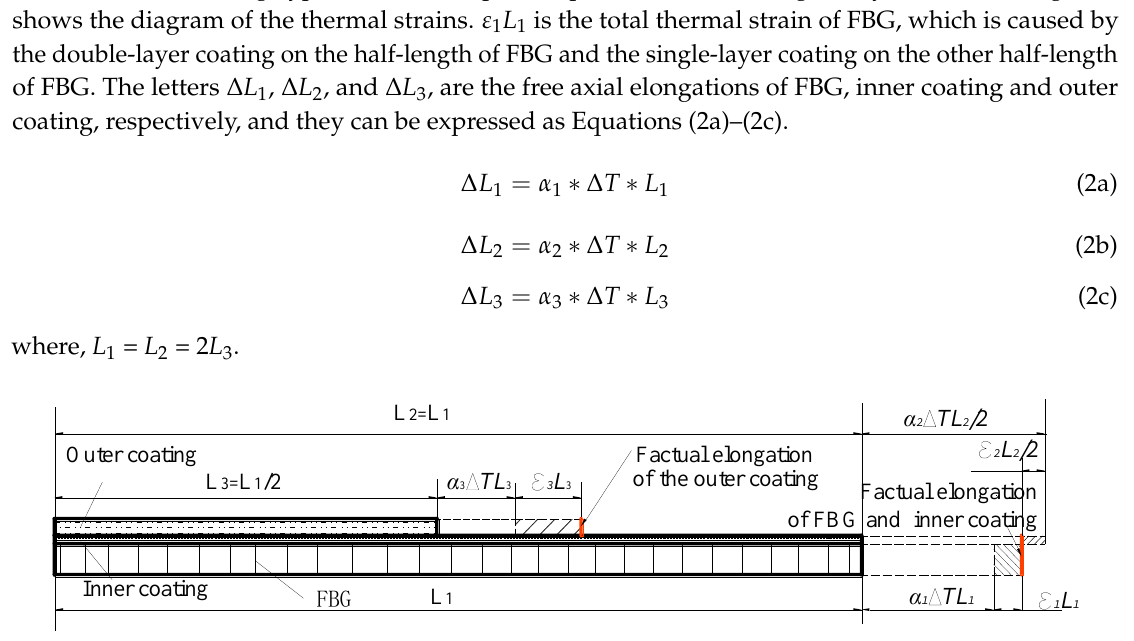
Figure 7. Diagram of the thermal strains of Type A.